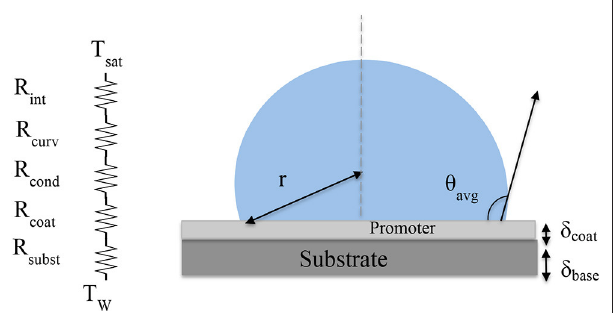
FIGURE 2 | Drawing of droplet on a condenser surface with the related thermal resistance network that includes the liquid-vapor interface resistance, the curvature resistance, the droplet conduction resistance, the hydrophobic promoter resistance, and finally the thermal resistance in the substrate. The hydrophobic promoter has the thickness of δ coat on hydrophobic sites and zero on hydrophilic